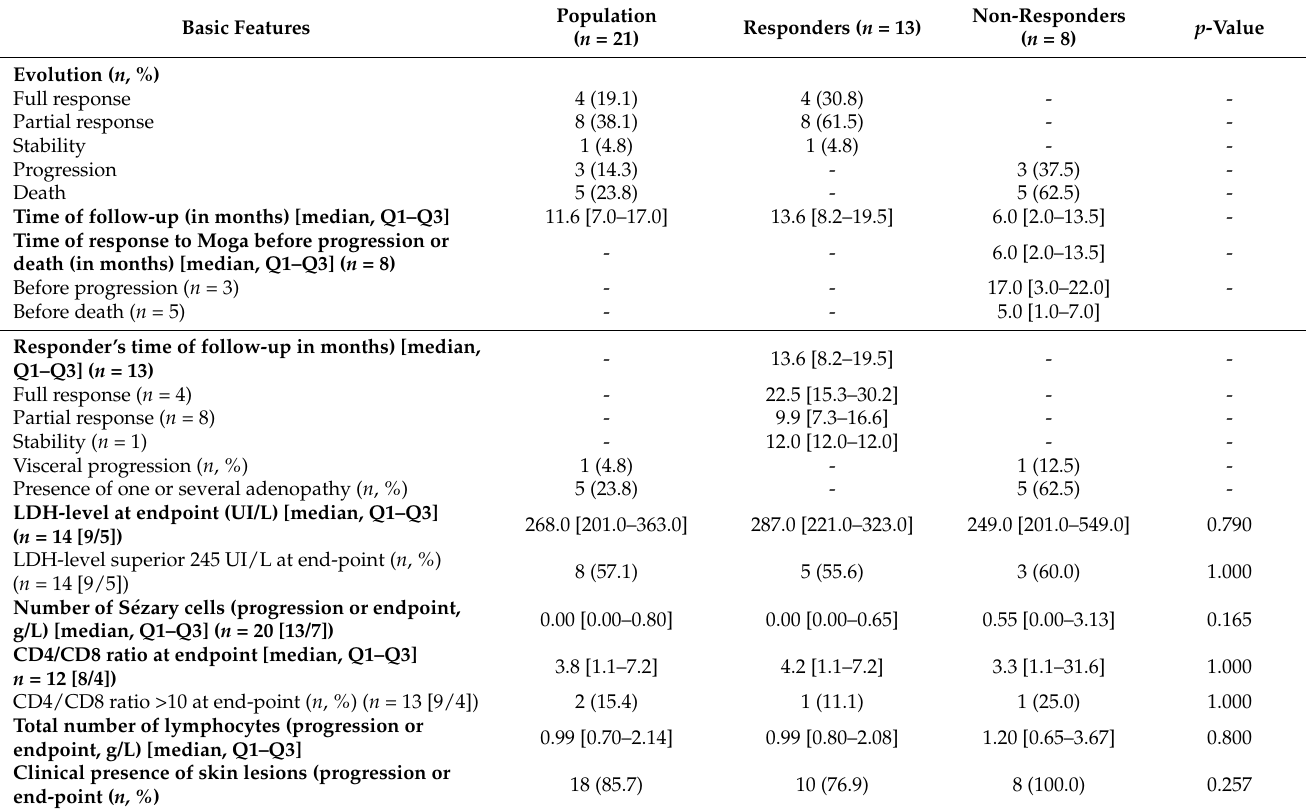
Table 2. Descriptive table of patient’s evolution with mogamulizumab. p -value obtained using Fisher exact test for qualitative variables and using Mann–Whitney U test for quantitative